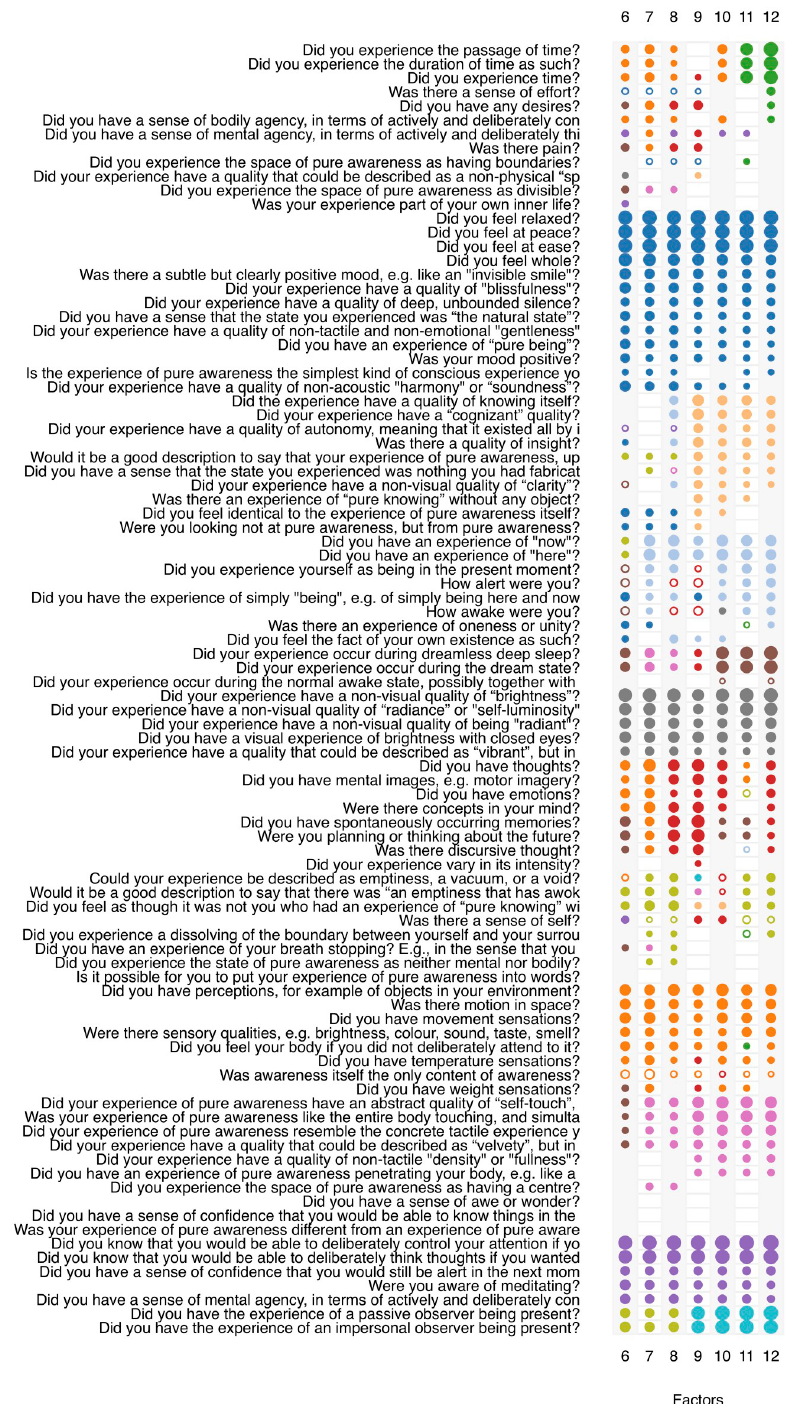
Fig 4. Results of exploratory factor analysis of the MPE-92M questionnaire (N = 1393). Questionnaire items are listed on the y-axis. Each column corresponds to a full factor solution with the number of extracted factors given on the x-axis. The size (area) of the circles is proportional to the factor loadings. Open circles indicate negative loadings, and loadings below 0.3 are not shown. Color represents factor membership. An attempt was made to identify the "same" factors across all factor solutions and color them identically. “Sameness” here is not objectively definable, but the degree of similarity was operationalized as membership in the same cluster following hierarchical cluster analysis. Items are sorted by factor membership and size of factor loading in the 12-factor solution, as it was this solution that was finally chosen as optimal.